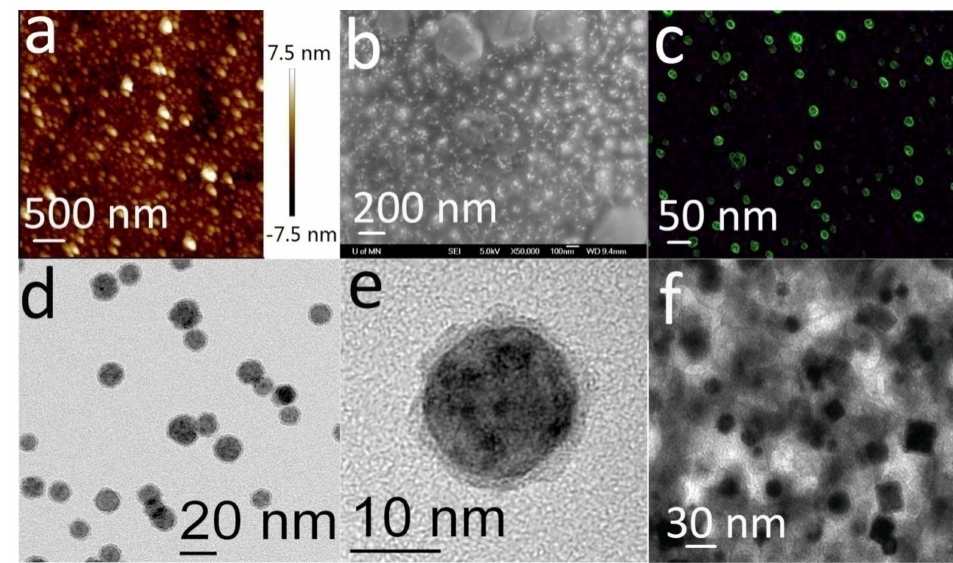
Figure 3. Surface modification and recognition of intermolecular recognition results of the SiNW device. ( a ) AFM image of the SiNW device modified with anti-HbA1c. ( b ) SEM image of the SiNW device modified with anti-HbA1c. ( c ) Fluorescence microscopy of CD44 protein modified through linker chains on SiNW. ( d – f ) TEM images of intermolecular recognition and binding on SiNW surfaces.